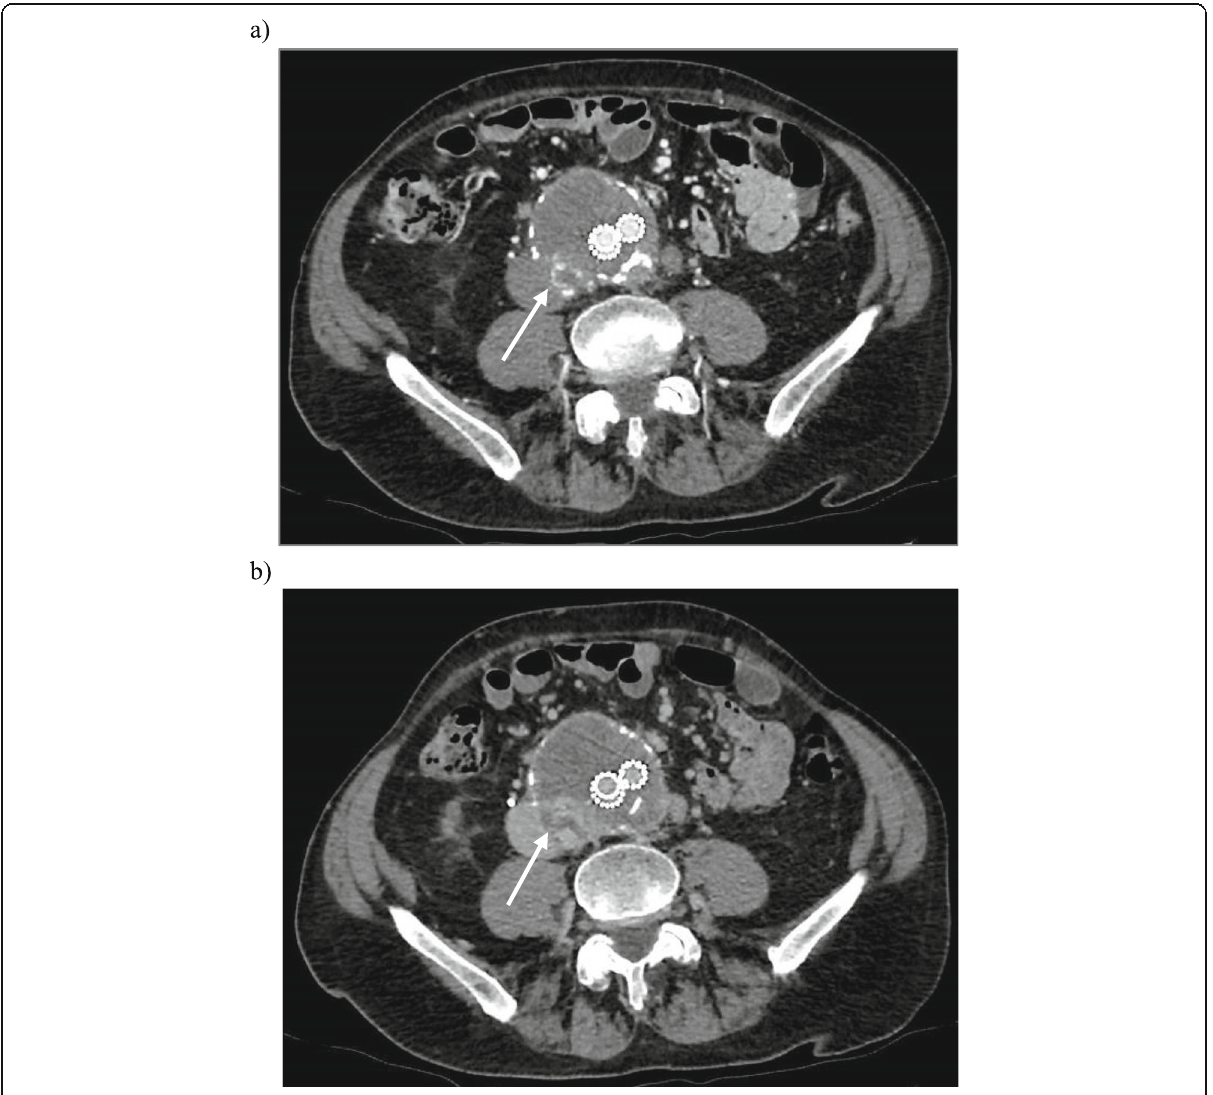
Fig. 1 Axial arterial phase CT images of the abdominal aorta demonstrate pooling of contrast (arrow) on the arterial phase ( a ) with increase pooling on the delayed phase ( b